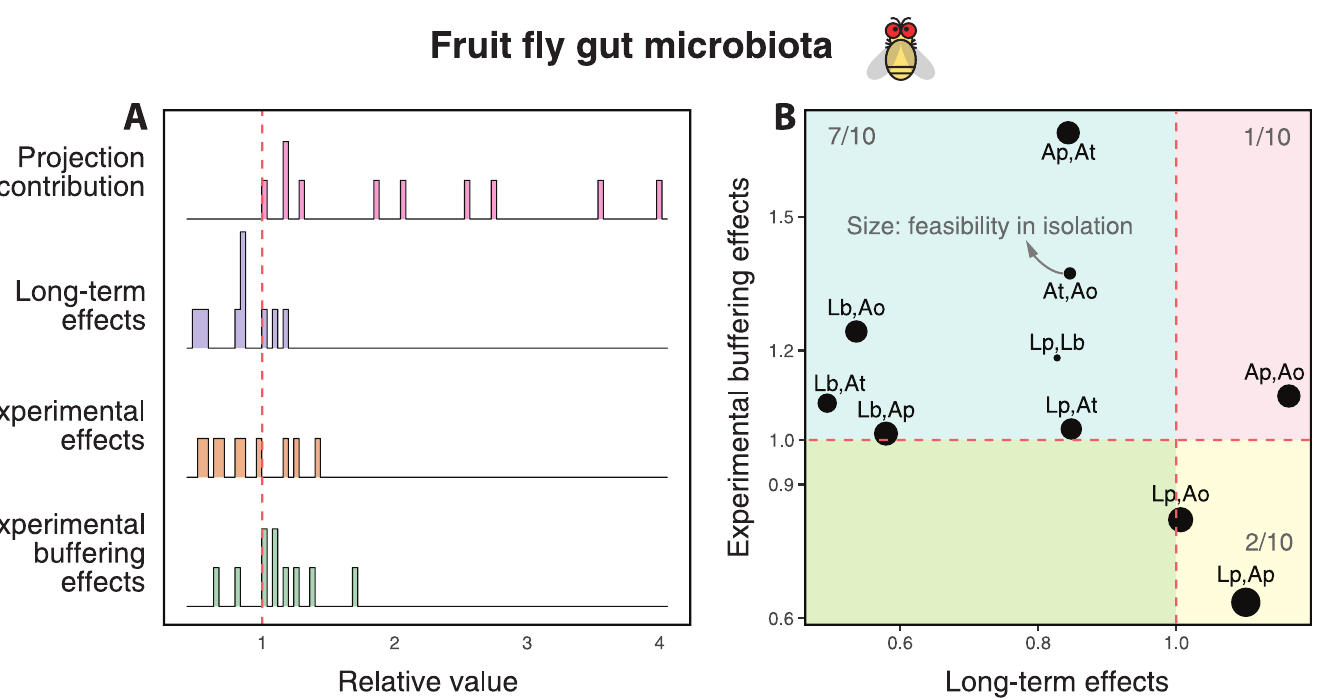
Fig 4. Comparing system-level effects among pairs within a five-species in vivo experimental system. This figure shows similar information to Fig 2, but using the experimental data and the experimentally-inferred interaction matrix. For each of the 10 pairs in the experimental fruit fly system, Panel A shows the projection distribution PC ð Z ; S Þ (first row pink distribution), long-term effects LE ð Z ; S Þ (second row blue distribution), experimental effects EE ð Z ; S Þ (third row orange distribution), and experimental buffering effects EBE ð Z ; S Þ (fourth row green distribution). Panel B shows the cartographic representation of how third-party species affect the long-term and short-term behavior of each of its constituent pairs. Long-term effects can be beneficial ( LE ð Z ; S Þ > 1 ) or detrimental ( LE ð Z ; S Þ < 1 ). In this experimental system, the majority of short-term effects tend to be beneficial ( EBE ð Z ; S Þ < 1 ) in line with negative-dominated interaction matrices (Fig 2B). See text or Fig 3 for all species